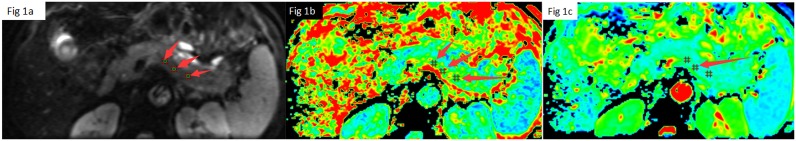
Three typical same ROIs placement of pancreatic body of healthy group on signal intensity image (a), ADC map (b) and FA map (C).